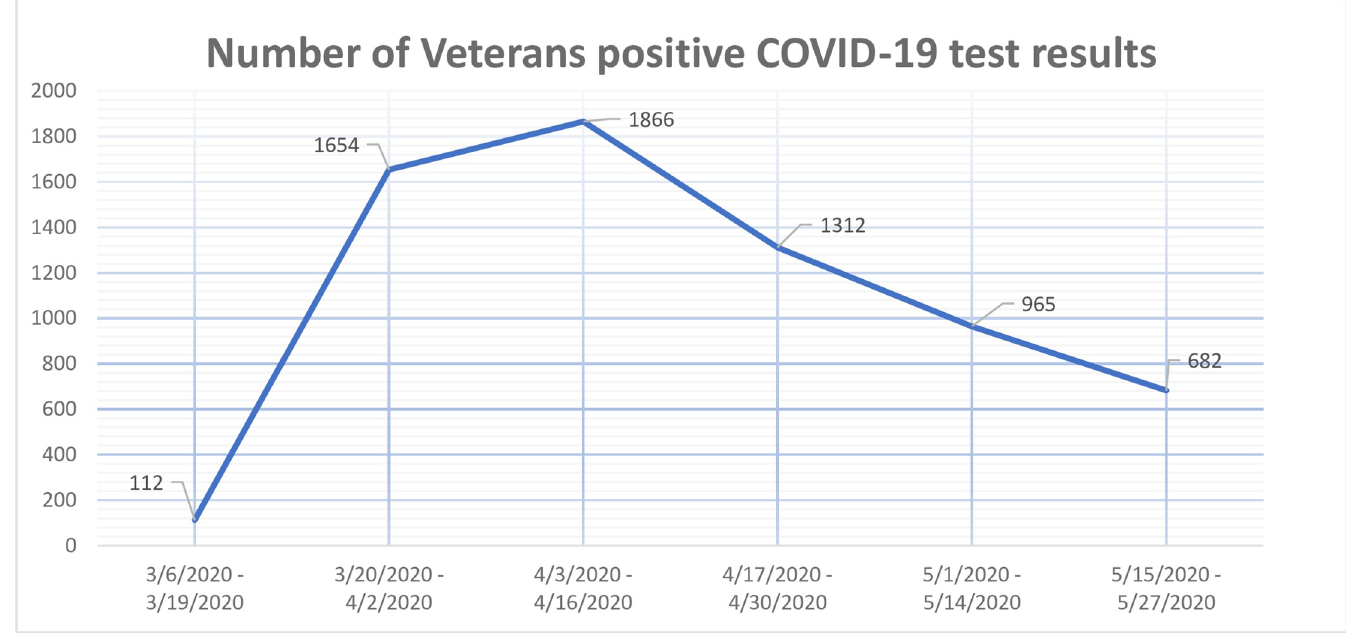
Fig 1. Number of Veterans in the cohort with positive COVID-19 test results per